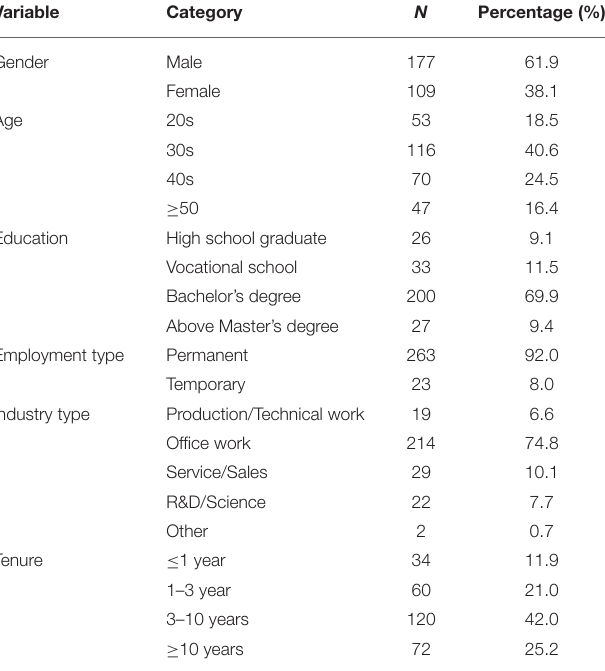
TABLE 1 | Survey respondents’